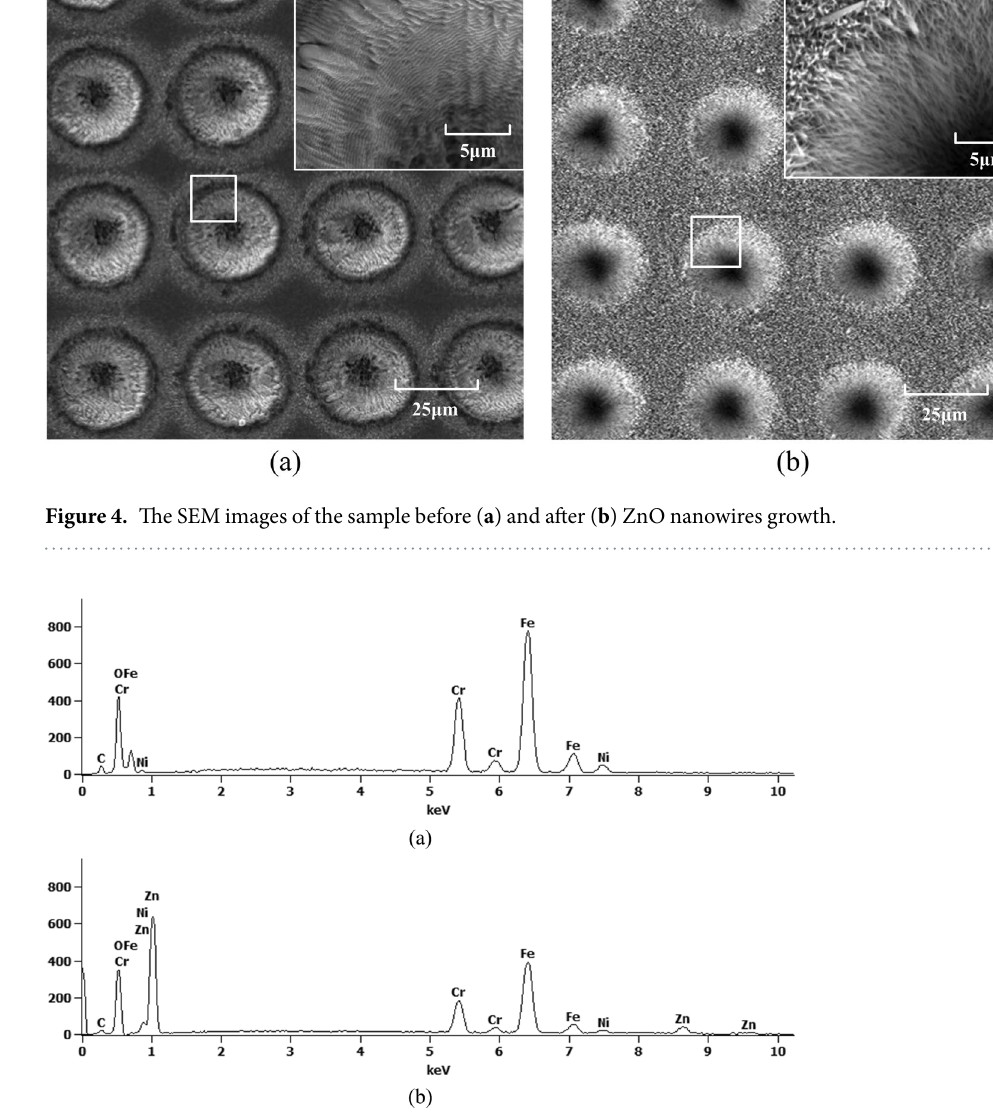
Figure 5. The EDS spectrums of samples before ( a ) and after ( b ) ZnO nanowires